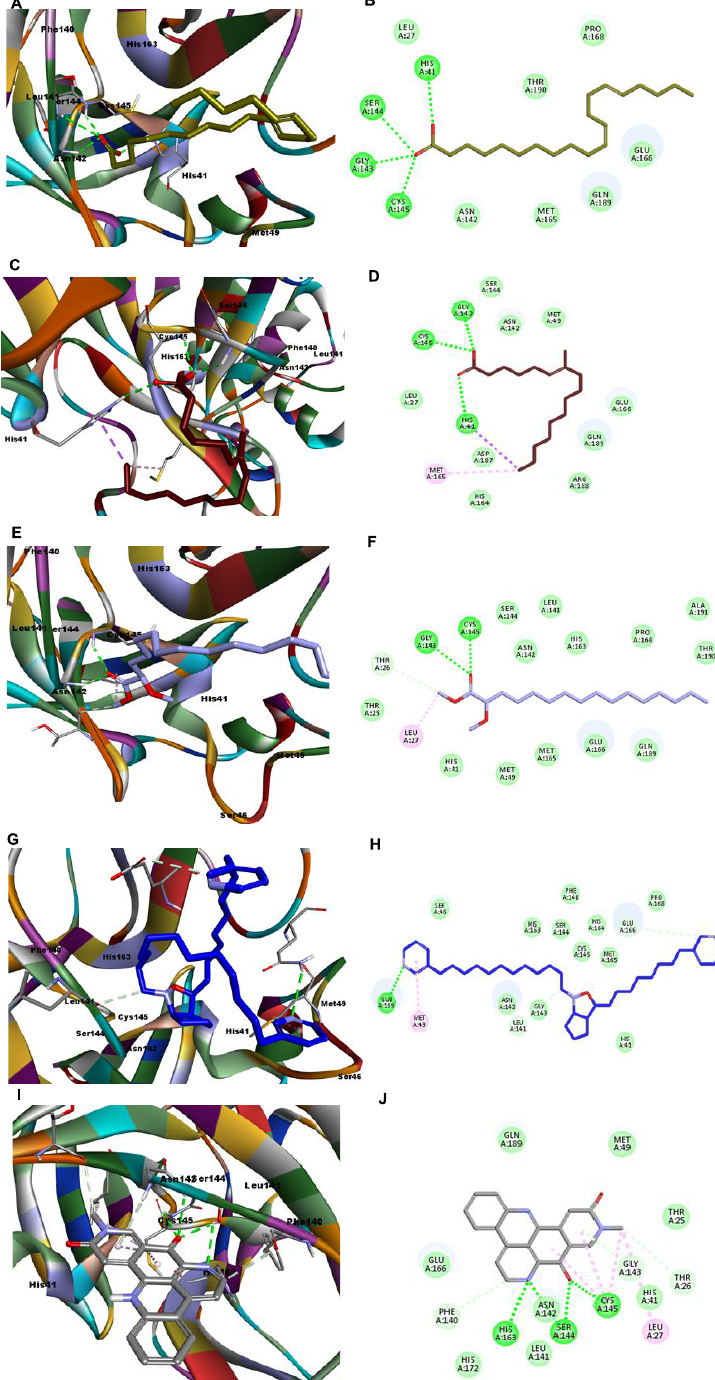
Figure 7. Depiction of 3D and 2D binding modes of compounds 10 ( A , B ), 8 ( C , D ), 9 ( E , F ), 7 ( G , H ), and 14 ( I , J ) into the active site of the 3CL protease (PDB ID: 6LU7). The docking study revealed that the virtually screened compounds, in particular the compounds nakinadine B ( 1 ), 20-hepacosenoic acid ( 11 ), and amphimedoside C ( 12 ), fit well into the pockets of both enzymes and may be effective against the new coronavirus via dual inhibition of SARS-CoV-2 RdRp and 3Cl main protease.